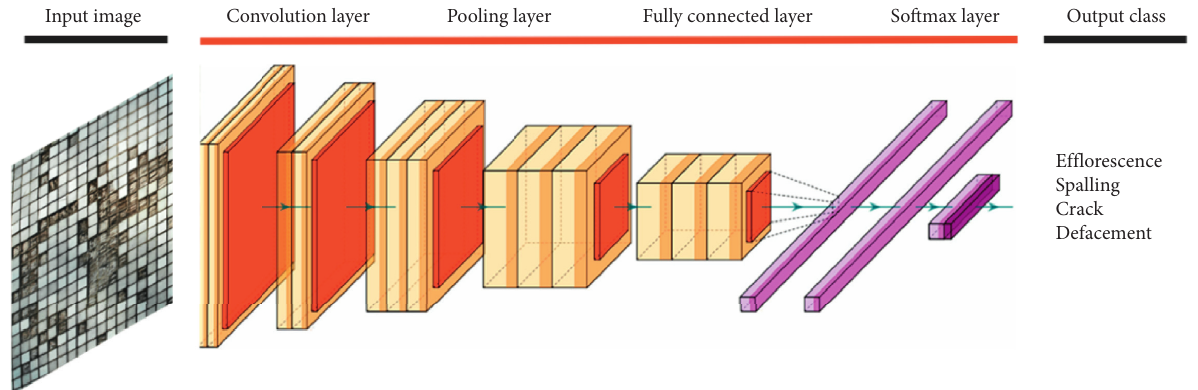
Figure 2: VGG-16 for transfer learning.